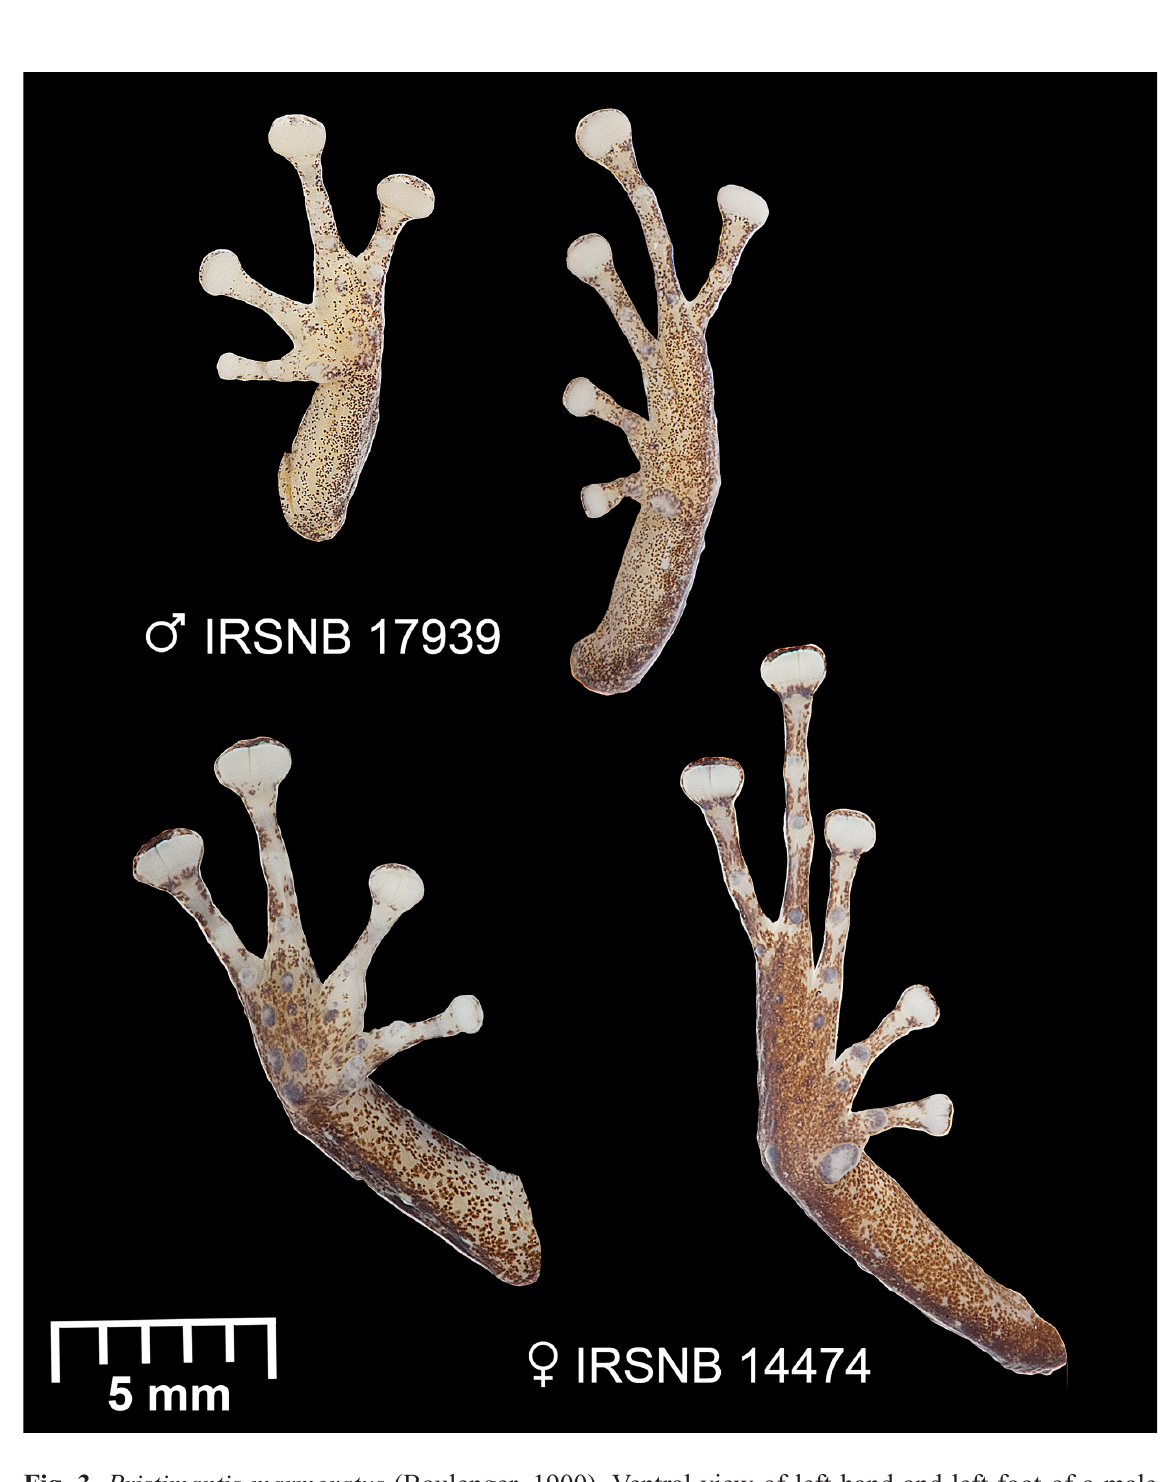
Fig. 3. Pristimantis marmoratus (Boulenger, 1900). Ventral view of left hand and left foot of a male (top), and ventral view of right hand and right foot of a female (below), both from Kaieteur National Park, Guyana. Photographs by